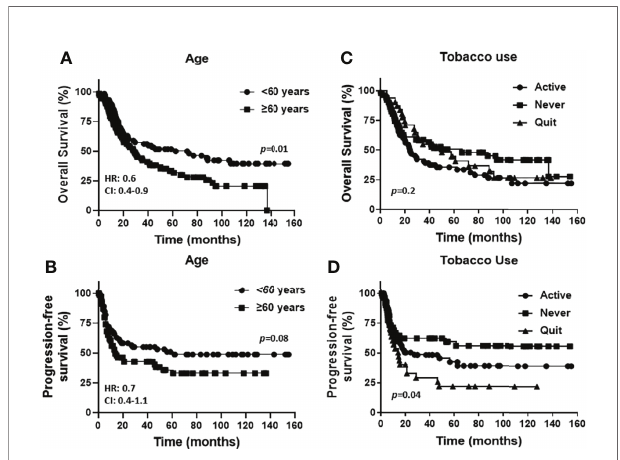
FIGURE 1 | Prognostic impact of age and smoking history in OSCCs. Shown are Kaplan-Meier estimates of the overall survival (A, C) and progression free survival (B, D) of OSCC patients strati fi ed by age [< 60 years or ≥ 60 years, (A, B) ] and tobacco use history [active, never or quit, (C, D) ]. HR: hazard ratio, CI: 95% con fi dence